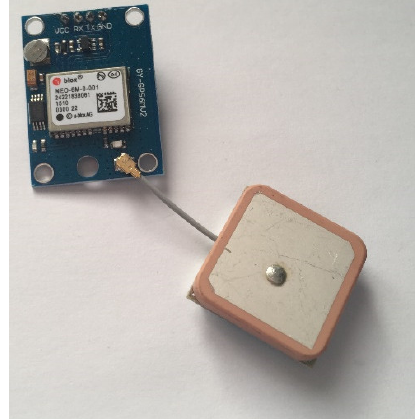
Figure 13. Photo showing the Neo-6M GPS Module with Ceramic Antenna.